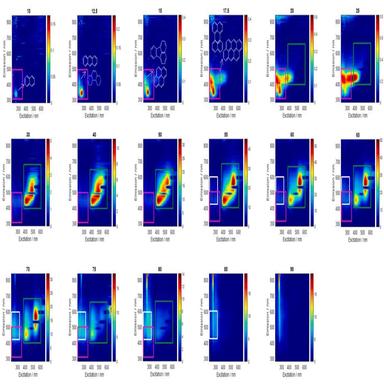
EEM of the methane diffusion flame as a function of the HAB from 10 to 90 mm. The emission spectra were obtained at 215, 220, 230, 240, 250, 265, 280, 290, 370, 405, 488, 532, 594, and 658 nm excitation wavelength.